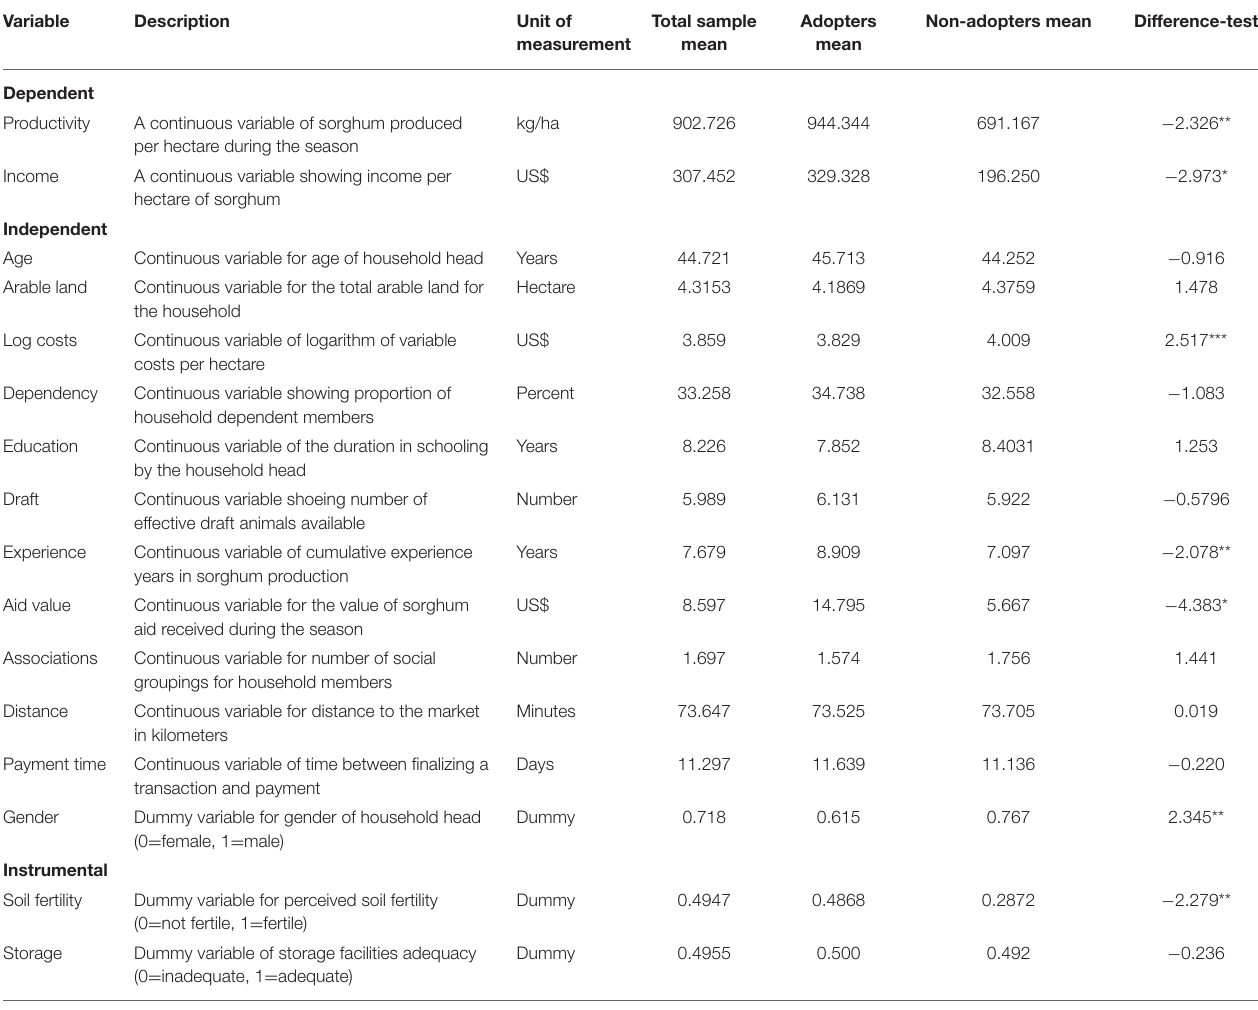
TABLE 2 | Description of variables included in the models and descriptive statistics.